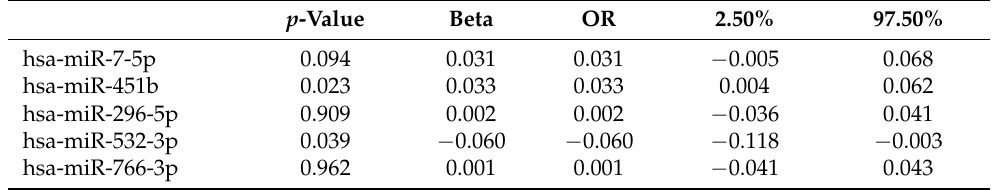
Table 5. List of replicated up and downregulated miRNAs and association with total IgE. p -value: computed with DESeq2. Beta and Odds Ratio (OR) from logistic regression are for a doubling of miR counts. 2.50%: lower bound of 95% confidence interval of odds ratio. 97.50%: upper bound of 95% confidence interval of odds